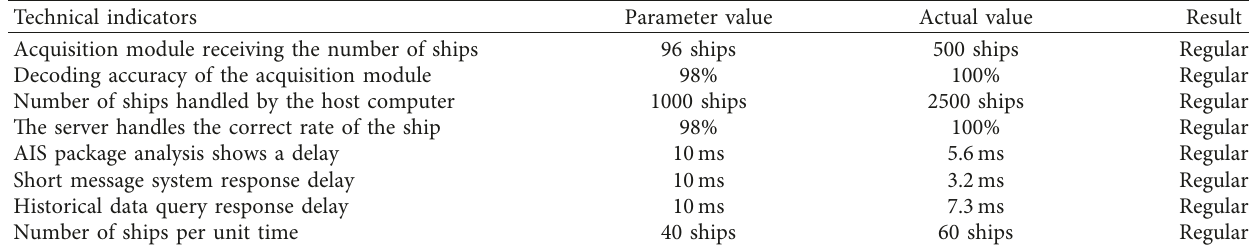
Figure 16: Short message sending Table 4: Experimental results.